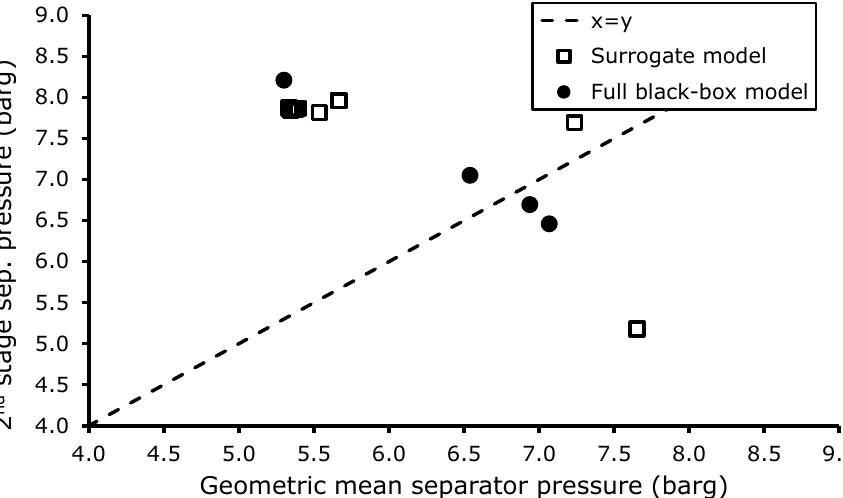
Figure 8. Optimal 2nd stage separator pressure as a function of the geometric mean separator pressure. Points shown for both optimal settings found using surrogate models as well as using the full black-box process simulation model.